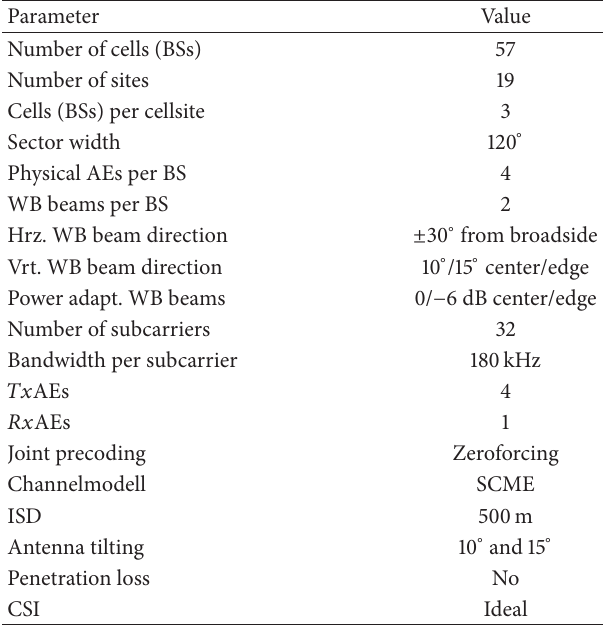
Table 1: Simulation parameter.